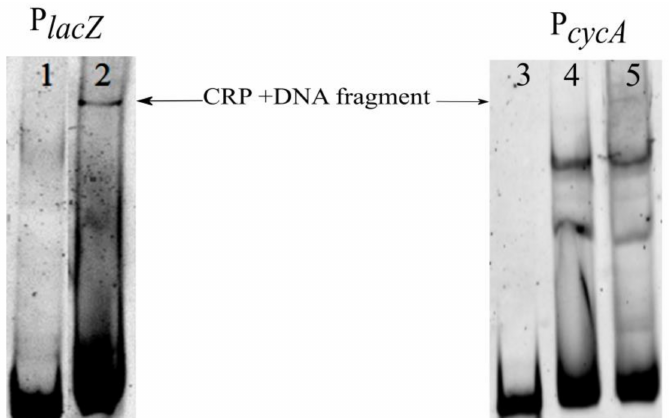
Figure 9. Results of electrophoretic mobility shift assay using P lacZ or P cycA DNA fragments with E. coli crude extract. 1, 3—free probe; 2, 5—fragment + E. coli K12 MG1655; 4—fragment + E. coli K12 MG1655 ∆